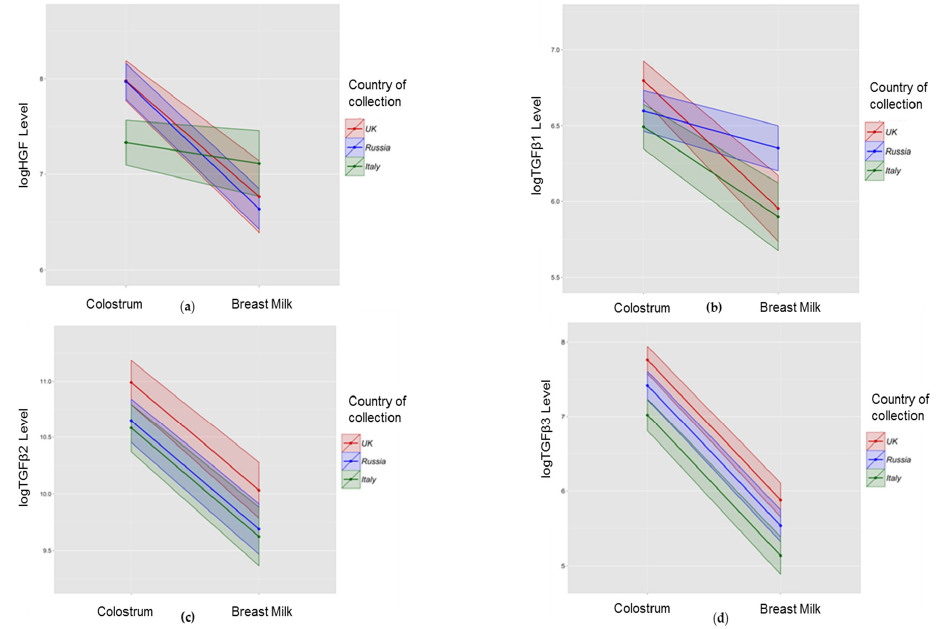
Figure 2. Association between site of collection and growth factor concentrations in colostrum and breast milk. Data shown are mean (bold line) and 95% CI (shaded area) for log transformed concentrations of HGF ( a ); TGF β 1 ( b ); TGF β 2 ( c ); and TGF β 3 ( d ) in the UK ( red ), Russia ( blue ), and Italy ( green ). A multilevel mixed ‐ effect regression model was used for all analyses which were adjusted to the following factors: Parity, Maternal Atopy, Maternal age, Site (Country) of collection, Mode of delivery, Mould presence at home, Pets at home or regular contact; Exposure to tobacco smoke, at recruitment; At least one self ‐ reported maternal infection during pregnancy; Maternal diet. Table 3. Concentration (pg/mL) of growth factors in colostrum and breast milk and exposures associated with the levels.